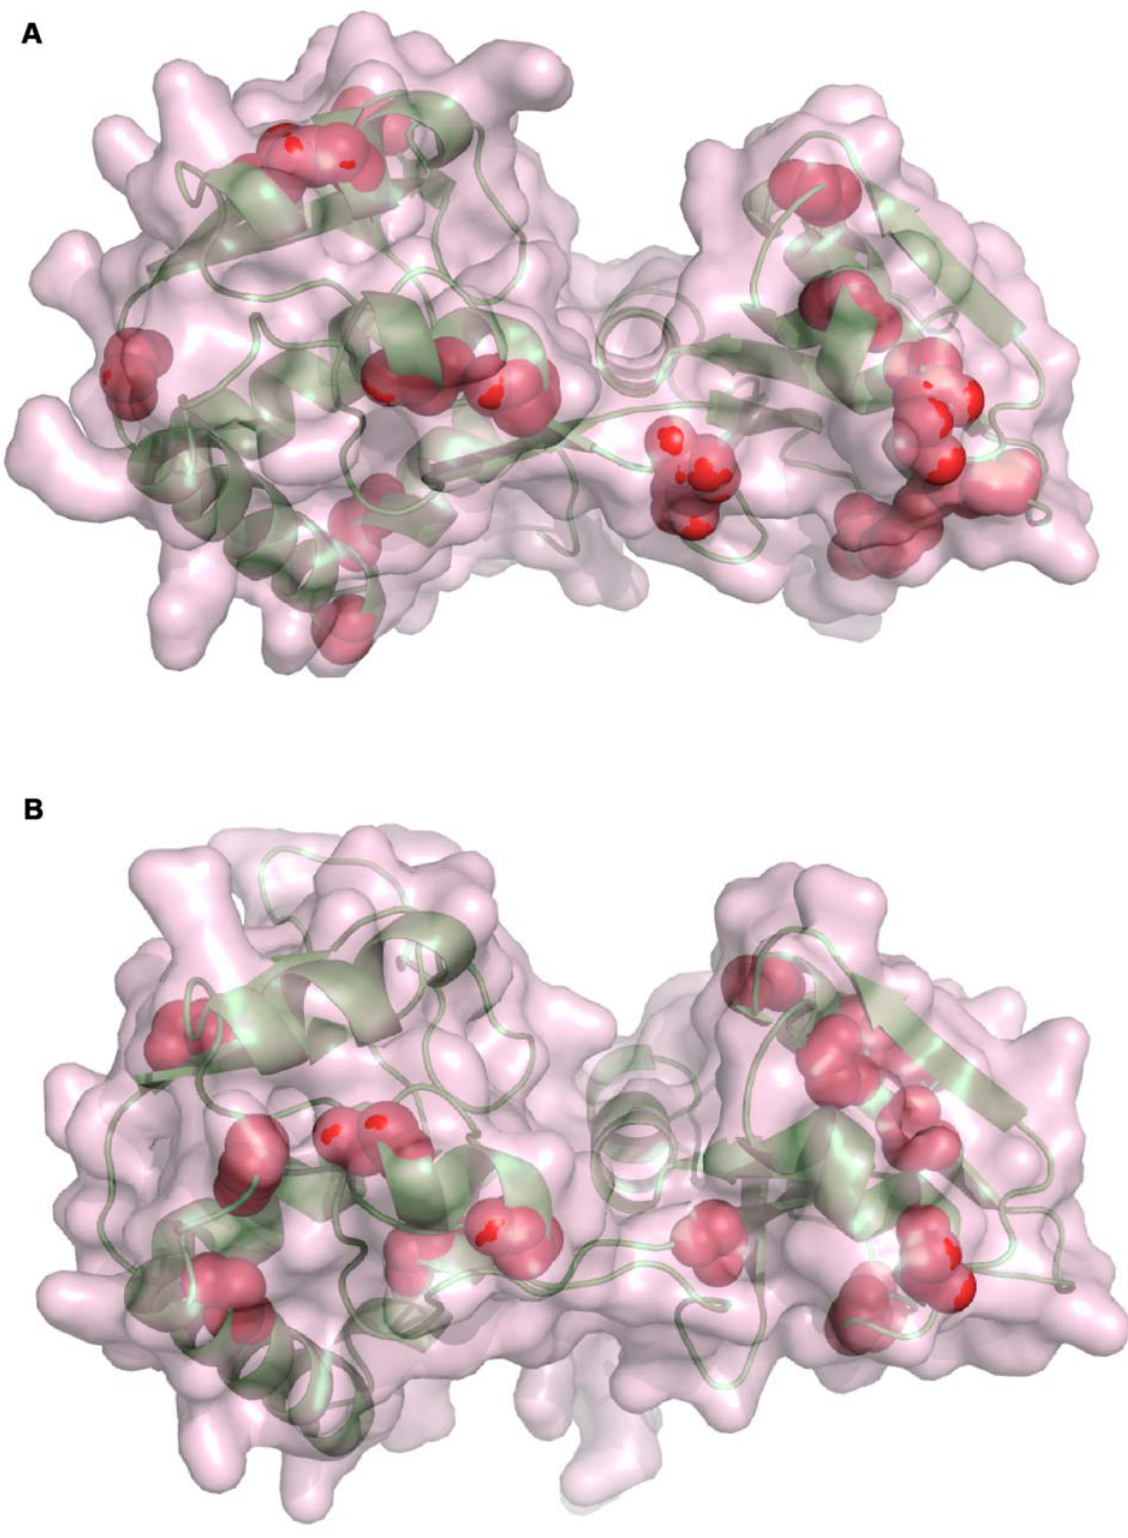
Figure 3. Structural models of VFT1 and VFT2. The models of VFT1 (A) and VFT2 (B) are based on the structure of the glutamine binding protein in an unliganded, open conformation (PDB 1GGG). The elements of secondary structure are shown in ribbon representation in lime green, and the surfaces of the proteins are shown in semi-transparency. The cavity of each of the two domains corresponds to the groove between the two lobes. The positions of the substitutions that distinguish the BvgS Bp and BvgS Bb types are depicted as red balls. Only the main chain atoms are shown. The rare substitutions have not been represented.